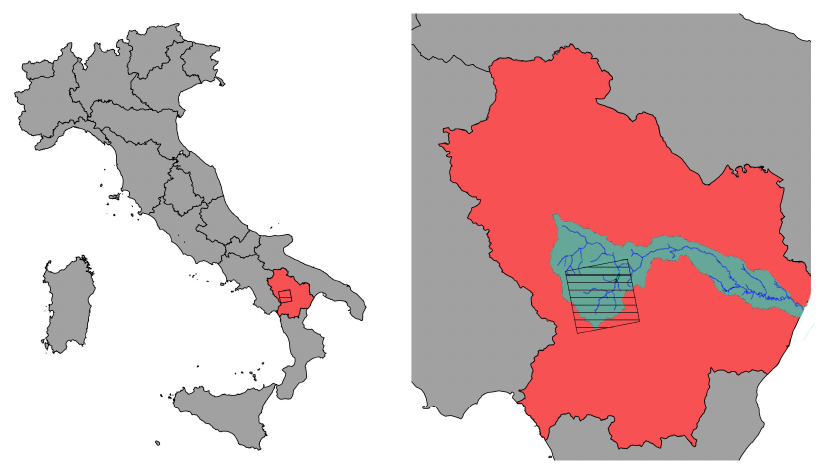
Figure 1. Basilicata region (red), Basento watershed (green), and Camastra basin (grid) (by QGIS). Table 1. QGIS™ location coordinates.